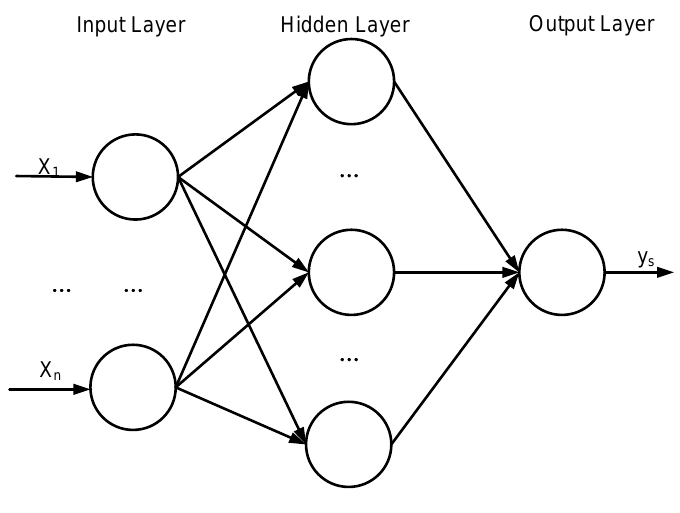
Figure 1. Diagram of ELM.